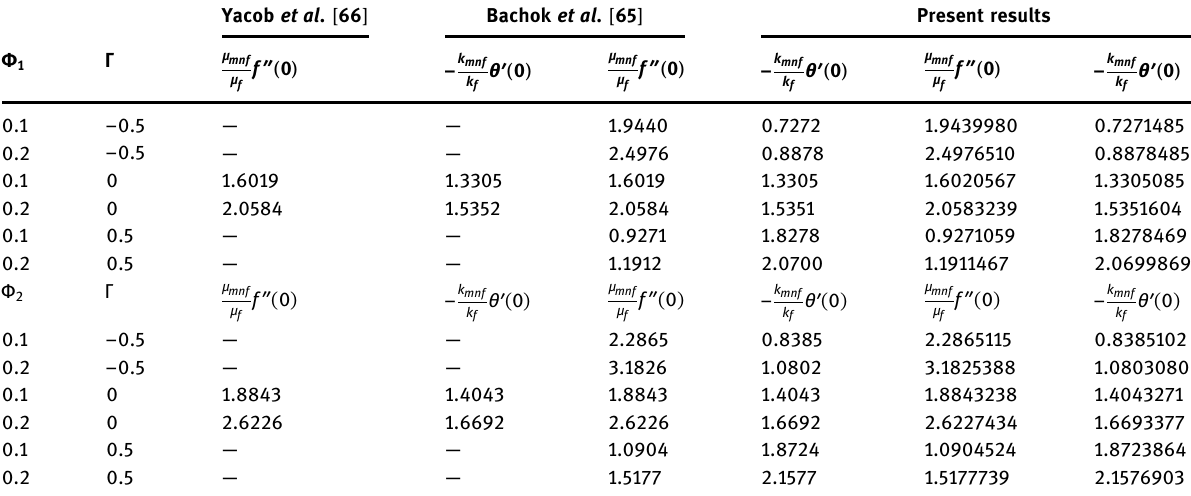
Table 5: Numerical values of coe ffi cient of skin friction and thermal rate for Al 2 O 3 /H 2 O SNF